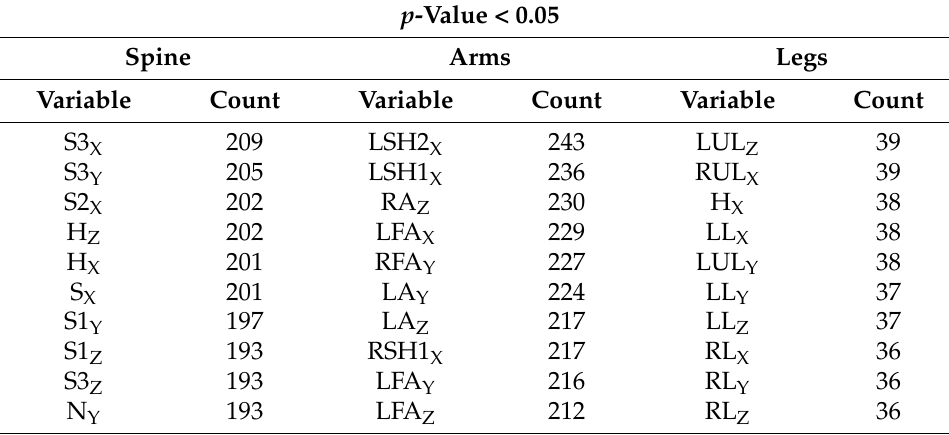
Table 2. G 2 : Airplane assembly.